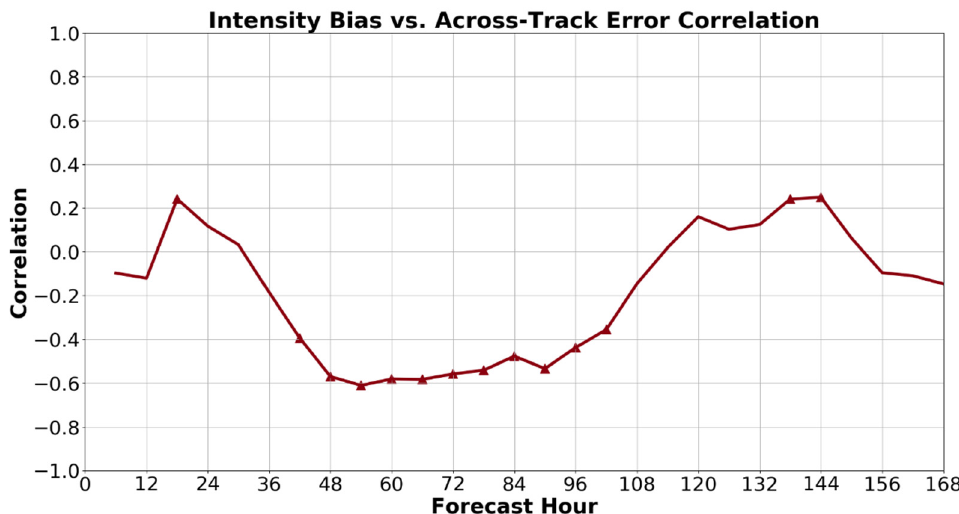
Figure 3. Correlation coefficient between across-track errors and intensity bias at each forecast hour from the ensemble set. Negative correlation means that larger cross-track errors are correlated with a weak intensity bias, and positive correlation means that larger cross-track errors are correlated with a strong intensity bias. The triangles indicate forecast hours where the relationship was statistically significant ( p < 0.05).